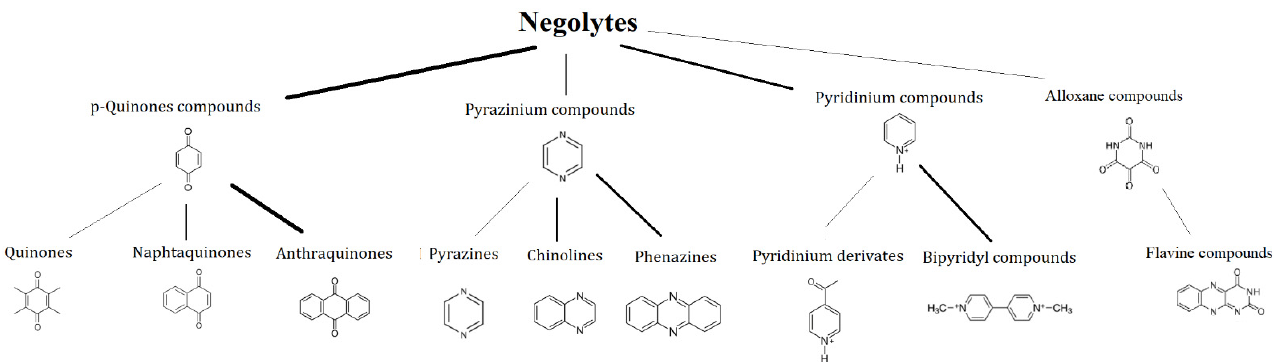
Figure 6. Redox potential ranges of redox couples discussed in this article. The color code of the bars indicates the pH regimes the redox potentials were measured, red for acidic pH range, green for neutral, and blue for alkaline pH range, grey means that alkaline as well as acidic electrolytes were considered.